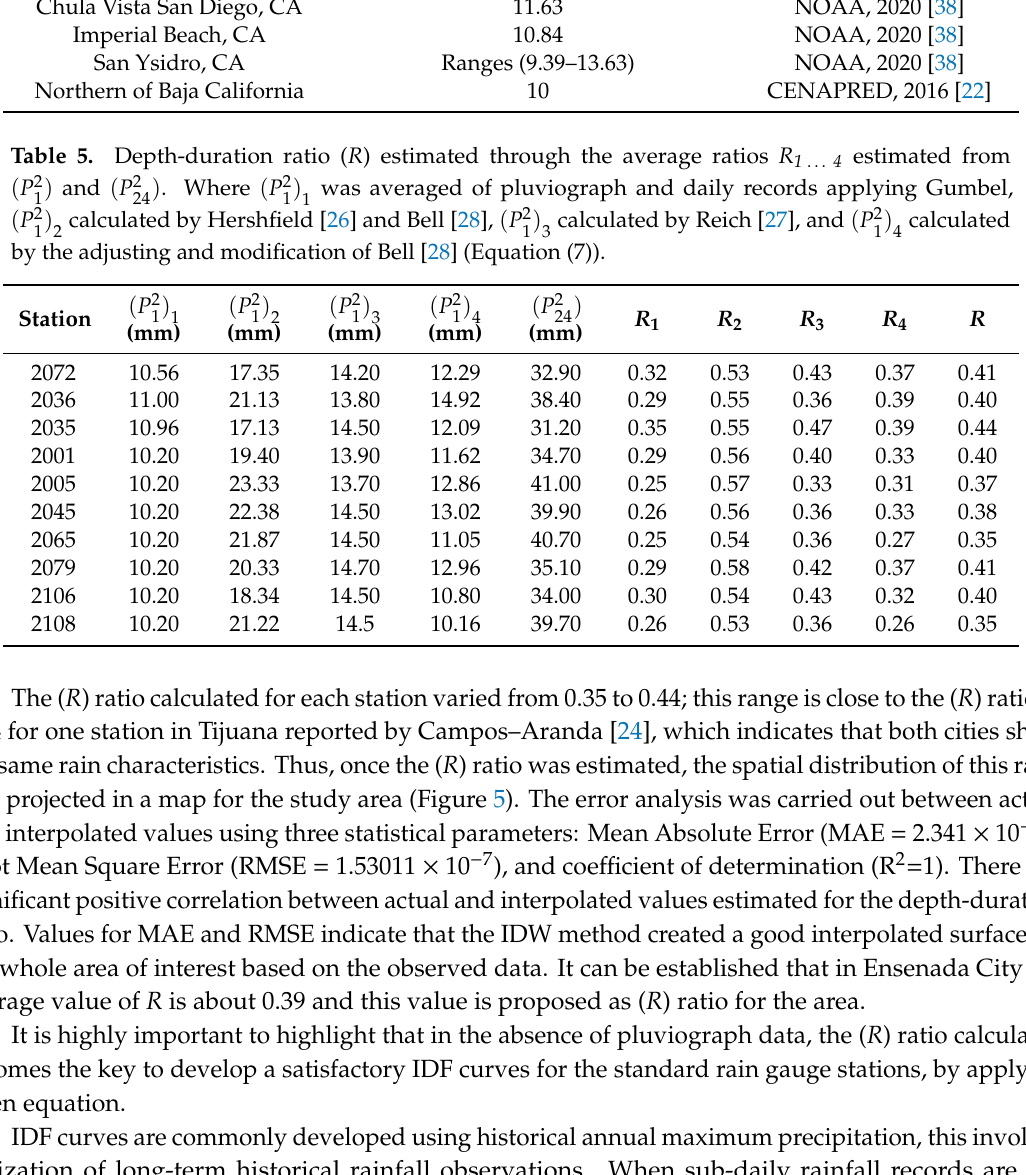
) calculated by Reich [27], and ( P 2 1 3